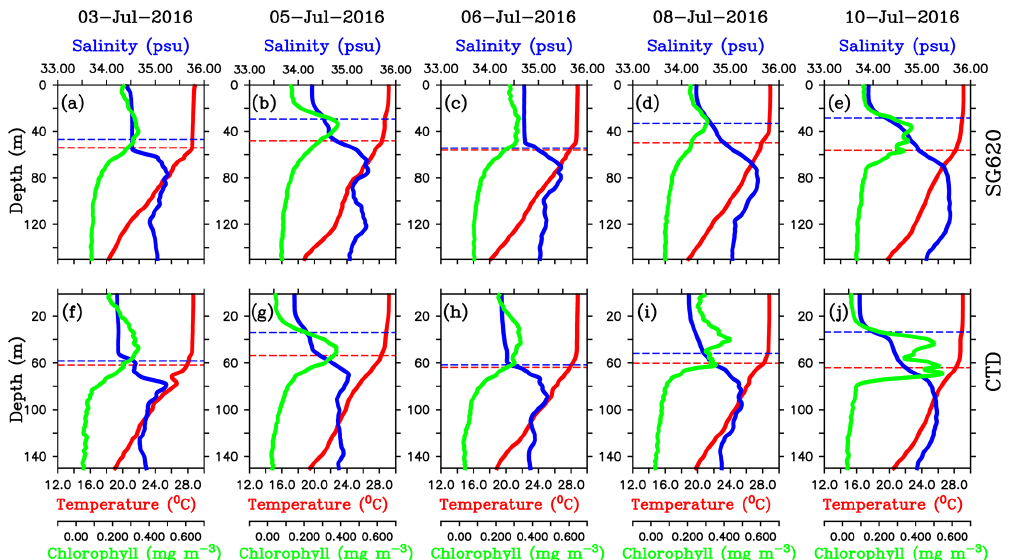
Figure 8. Daily mean vertical profiles of temperature ( ◦ C; red), salinity (psu; blue) and chlorophyll (mgm − 3 ; green) for selected days from (a–e) SG620 and (f–j) CTD. The blue dashed line indicates the mixed layer depth, which is calculated as the depth where density is equal to the sea surface density plus an increase in density equivalent to a reduction in temperature of 0.8 ◦ C. The red dashed line indicates isothermal layer depth (ILD) which is calculated as the depth where the temperature is cooler than SST by 0.8 ◦ C. The region between the MLD and ILD represents the barrier layer.